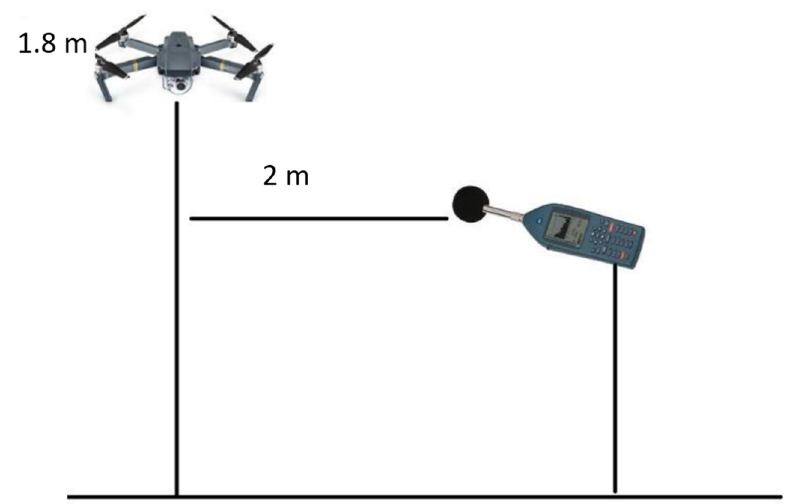
Figure 2. Measurements of acoustic parameters.